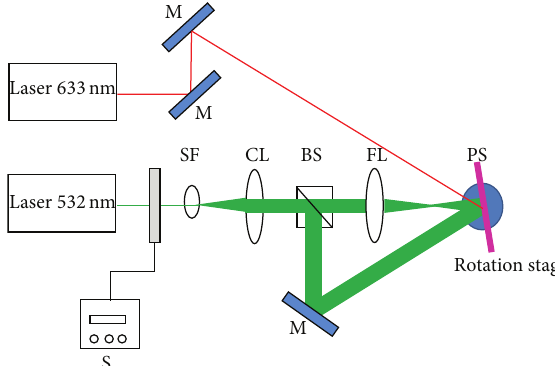
Figure 2: Experimental set-up for recording focussing transmission holograms: S: shutter, CL: collimating lens, BS: beam splitter, SF: spatial filter, M: mirror, FL: focusing lens, and PS: photopolymer